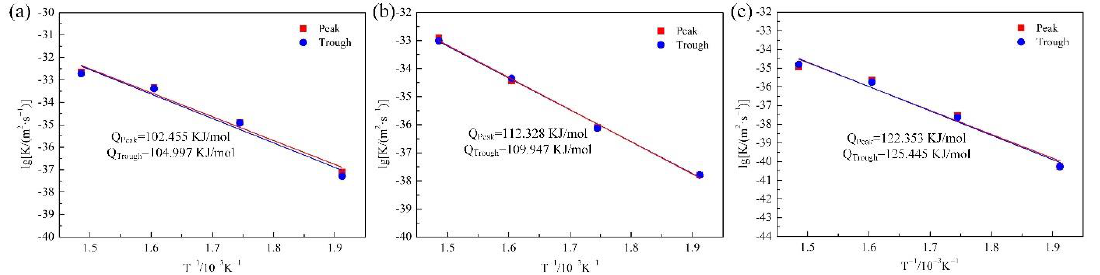
Figure 6. Arrhenius plot for the growth rate of the intermetallic layer: ( a ) CuAl 2 , ( b ) Cu 9 Al 4 , ( c ) CuAl.